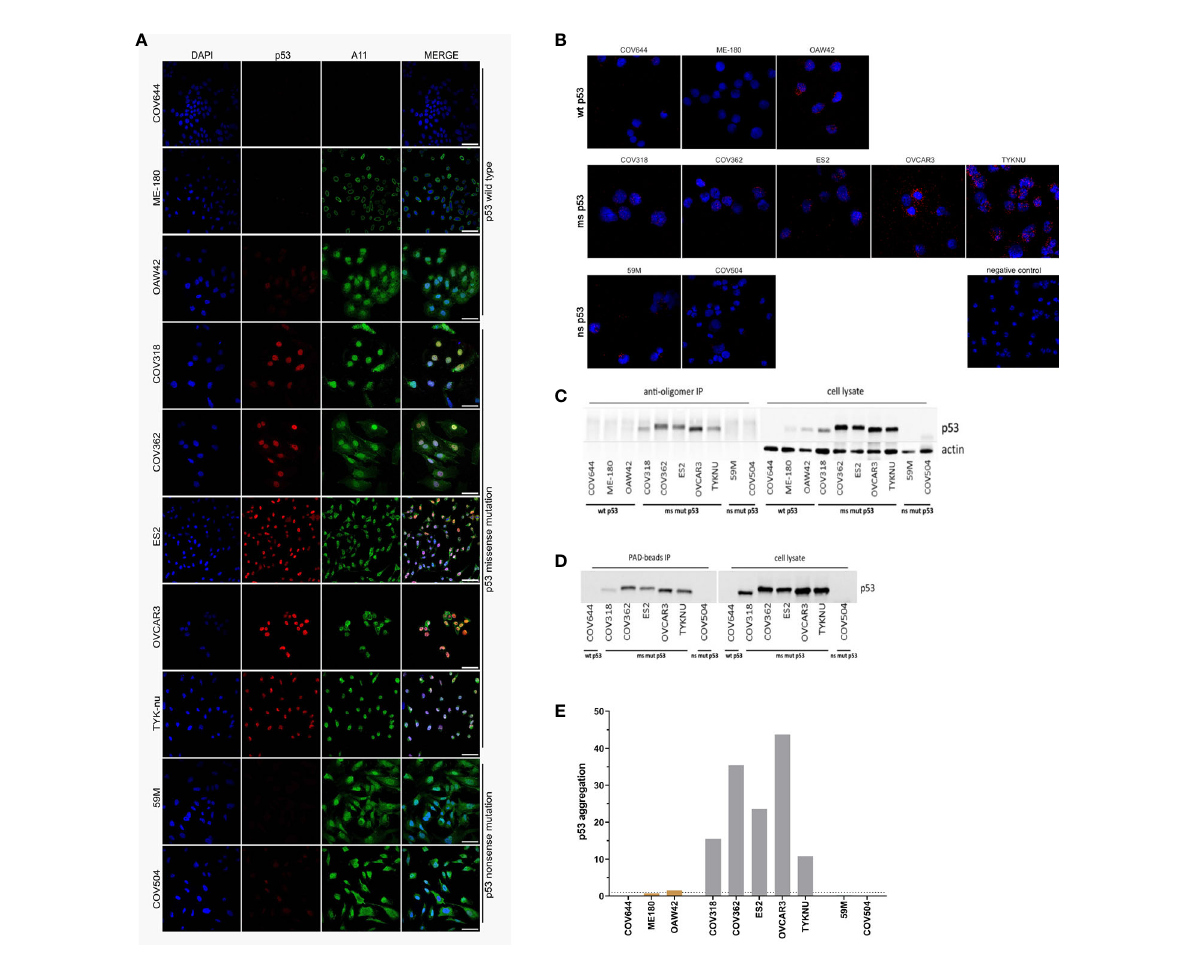
FIGURE 2 Detection of p53 aggregates in ovarian and cervical cancer cell lines. (A) Immuno fl uorescence co-localization assay (co-IF) using an anti-p53 (red) and an anti-oligomer (A11, green) antibody. Nuclear counterstaining was performed using DAPI. Scale bars: 50 µm. (B) Proximity ligation assay (PLA): red dots indicate p53 aggregates and nuclei in blue. (C) Co-immunoprecipitation (co-IP) was performed by using the anti-oligomer A11 antibody for the pull-down of amyloid proteins. Immunoblots for p53 were performed to show that p53 was present as oligomeric aggregates. (D) Amyloid proteins were immunoprecipitated with Seprion-coated beads (PAD-beads) and an immunoblot was performed to show that the aggregates consisted of p53. (E) The p53-Seprion-ELISA was performed to speci fi cally detect p53 aggregates Dashed line, cut-off value for positive samples (p53 aggregation >1). Absorbance values were normalized to the total protein concentration. Grey, missense mutated cell lines; brown, wild-type p53 cell